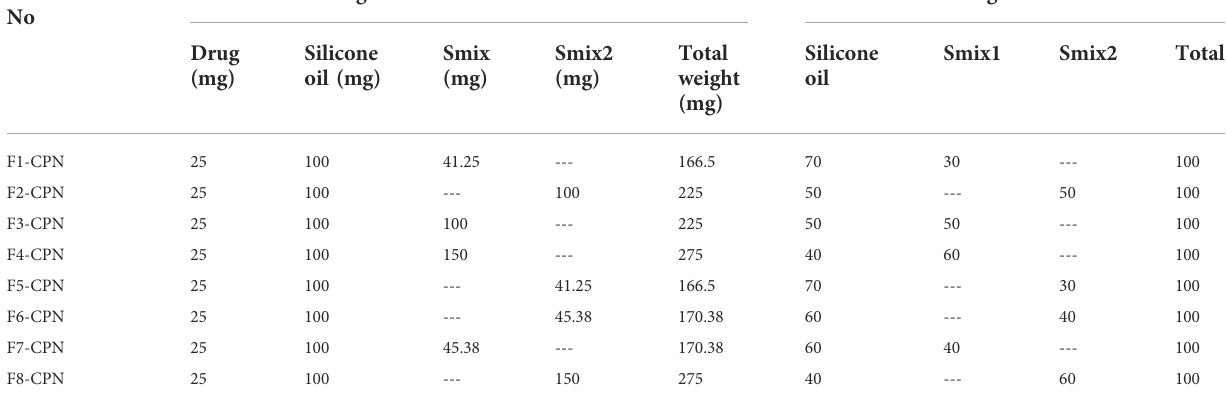
TABLE 3 Formulation composition name and amount.